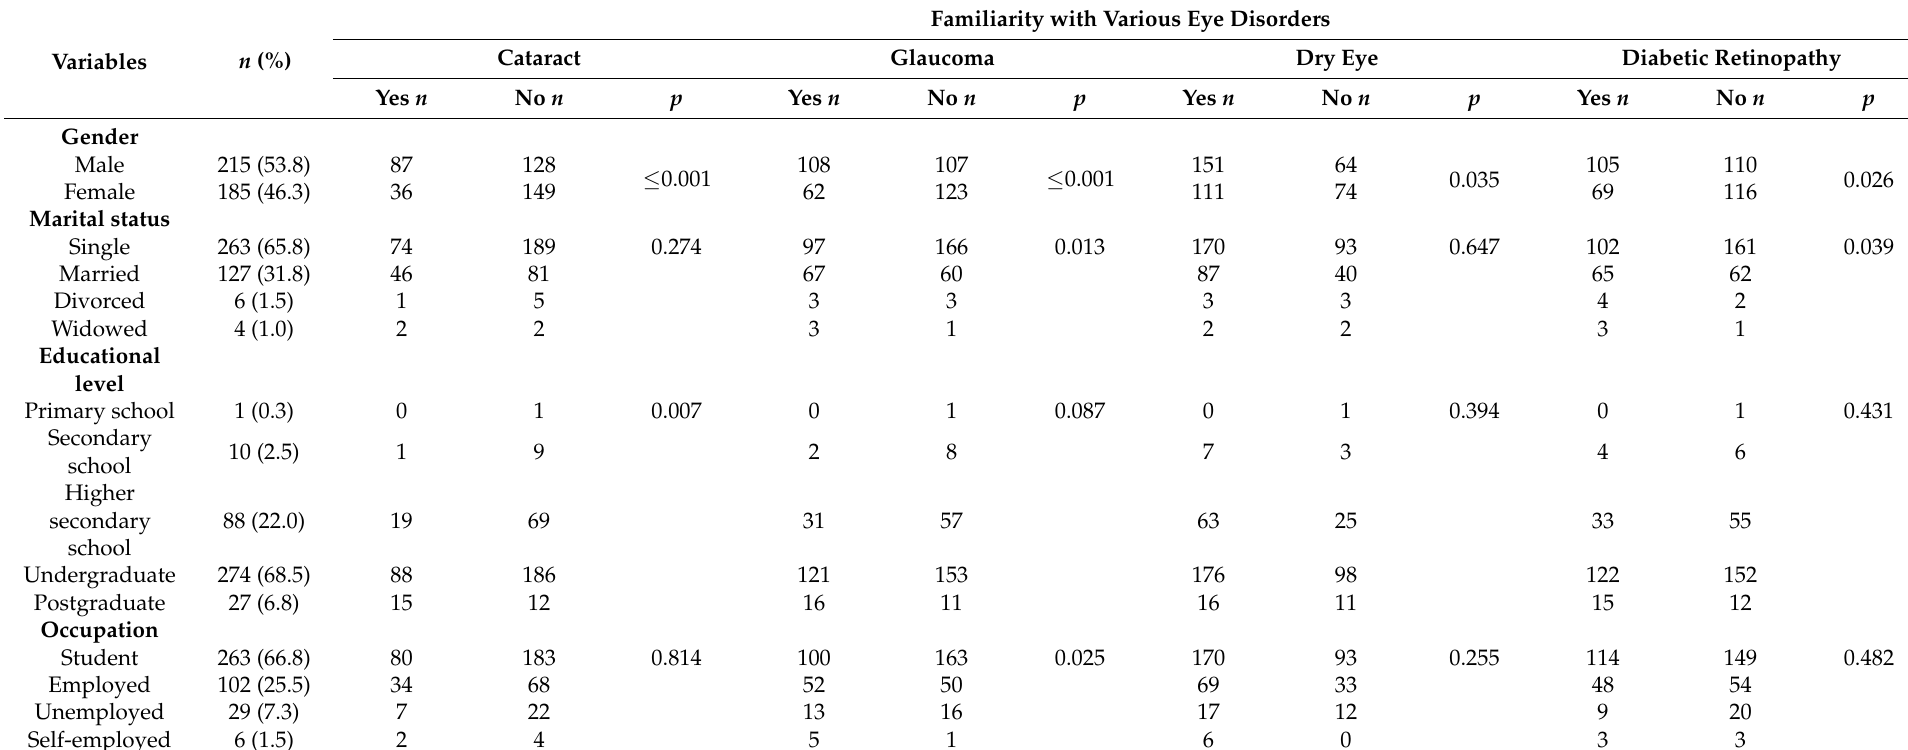
Table 1. Association between demographic data and level of awareness of various eye